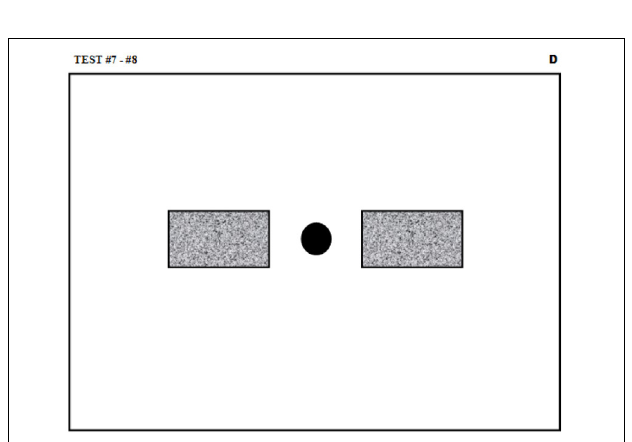
The targets are 15mm in diameters and are positioned at the apexes of equilateral triangles with vertexes of (A) 135mm, (B) 90mm, and (C) 45mm long.